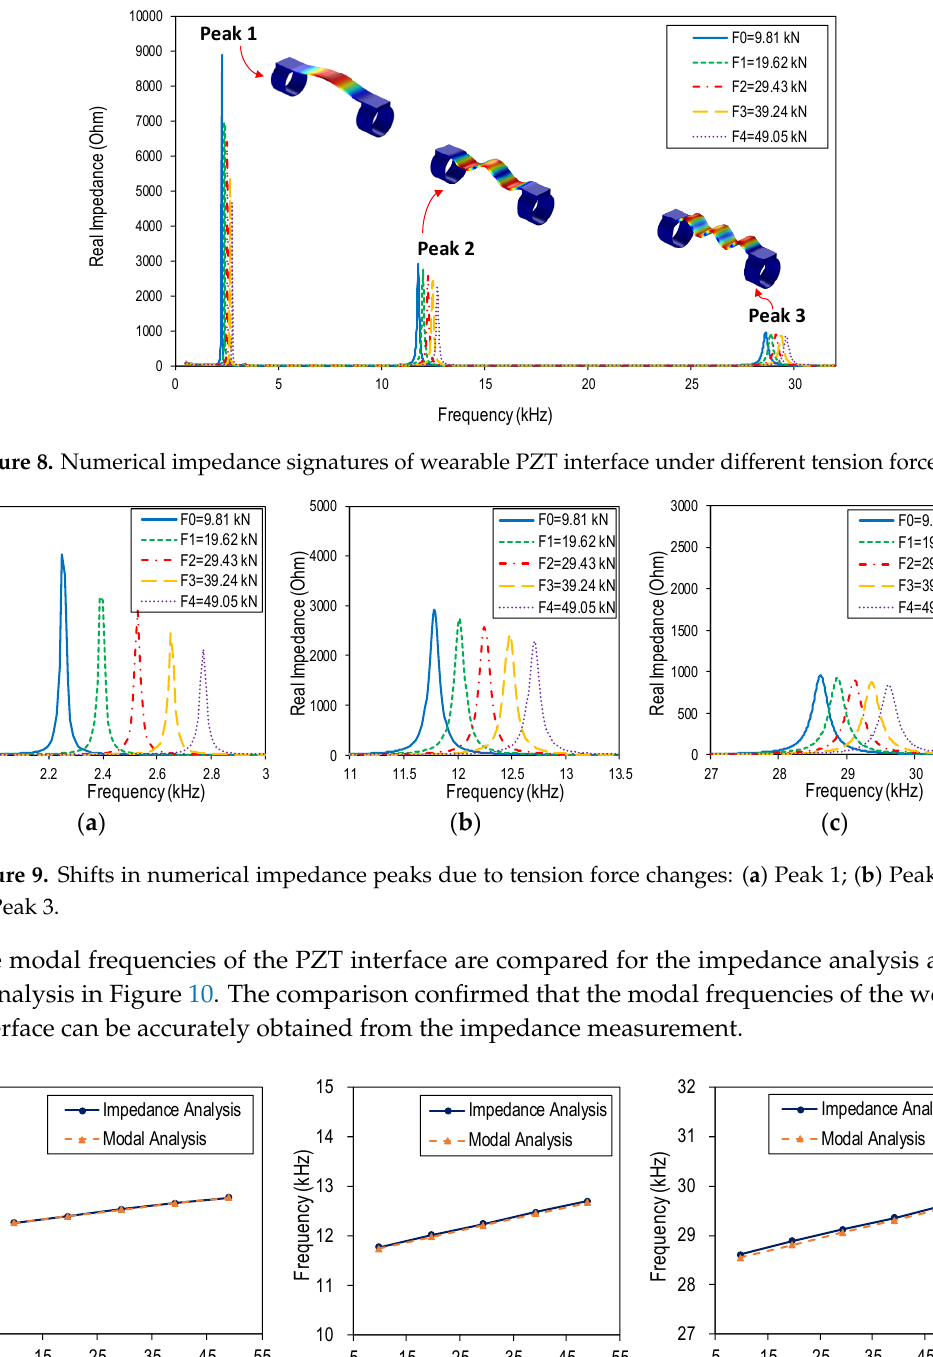
Figure 10. Natural frequencies of wearable PZT interface: numerical impedance analysis vs. modal analysis: ( a ) Peak 1; ( b ) Peak 2; ( c ) Peak 3.